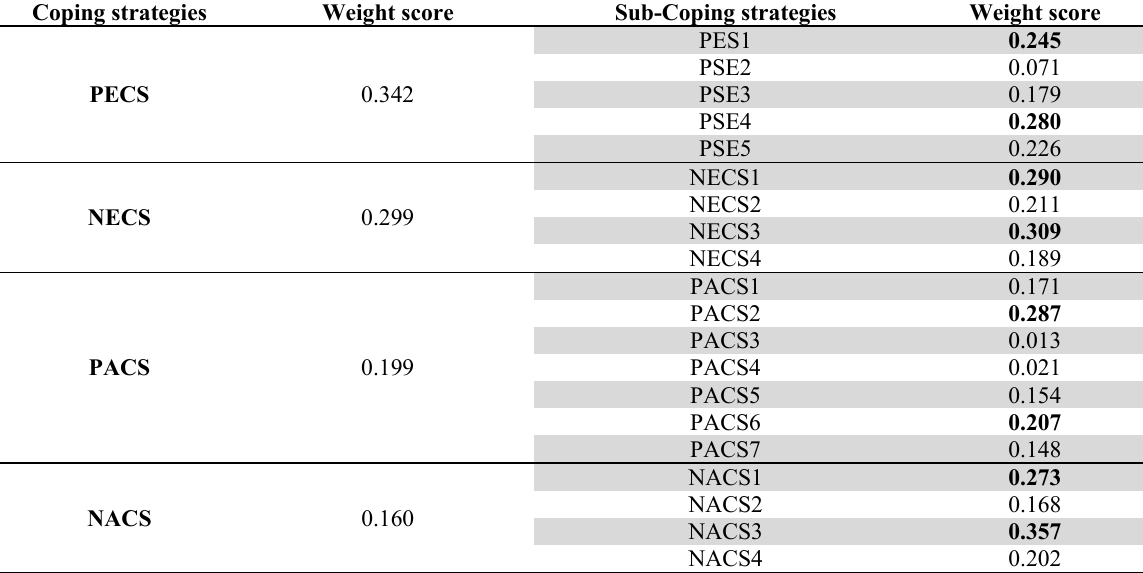
Weight vector of coping strategies and sub-coping strategies Coping strategies Weight score Sub-Coping